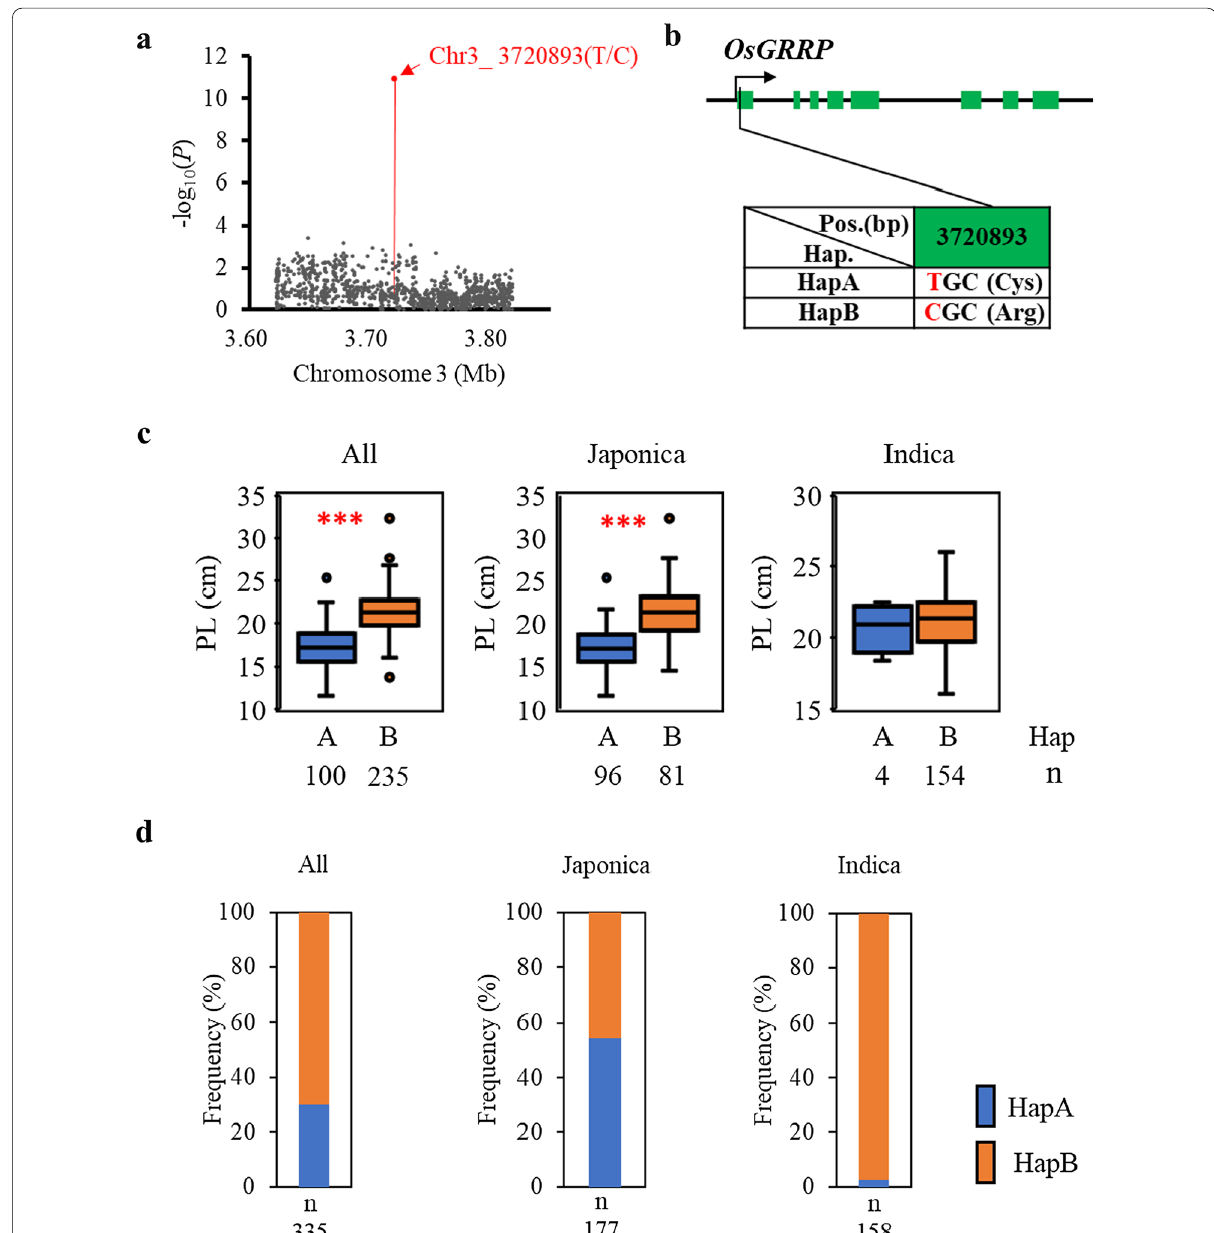
Fig. 4 Haplotype analysis of the candidate gene in qPL3-7. a Local Manhattan plot of qPL3-3 on chromosome 3. The red arrow indicates the position of the lead SNP. b Schematic representation of OsGRRP gene structure and the position of peak SNP used for haplotype analysis. Green boxes indicate exons. c Box plots for panicle length (PL) in the two haplotypes of OsGRRP in all, japonica, and indica accessions in 2017. Number of accessions (n) of each haplotype (Hap) in each panel given under the x-axis. Boxes show median, and upper and lower quartiles. Whiskers extend to 1.5 the interquartile range, with any remaining points indicated with dots. *** P < 0.001 (Welch two sample t -test). d Frequencies of the two × OsGRRP haplotypes in all, japonica, and indica accessions. n, number of accessions in each